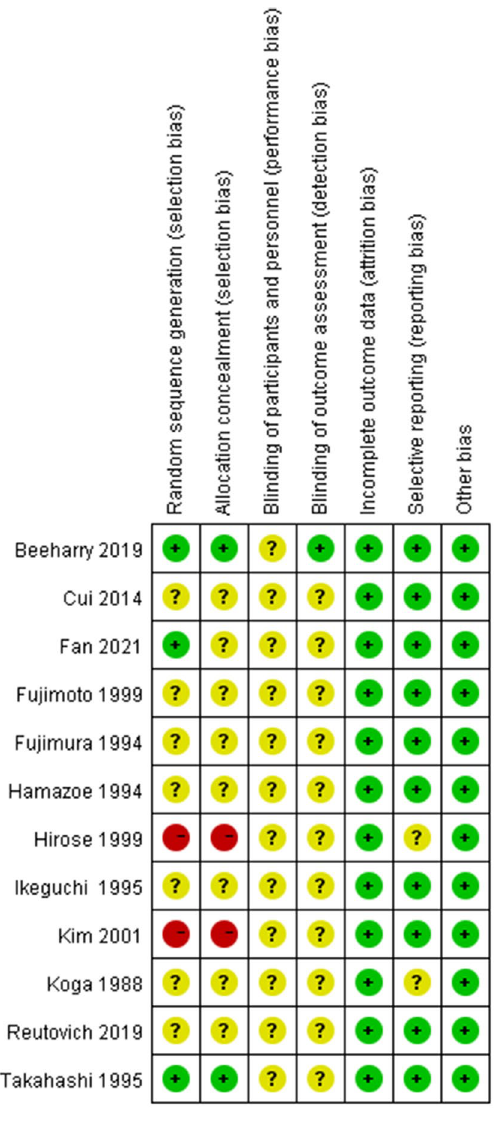
Figure 3. Risk of bias summary: review authors’ judgements about each risk of bias item for each included